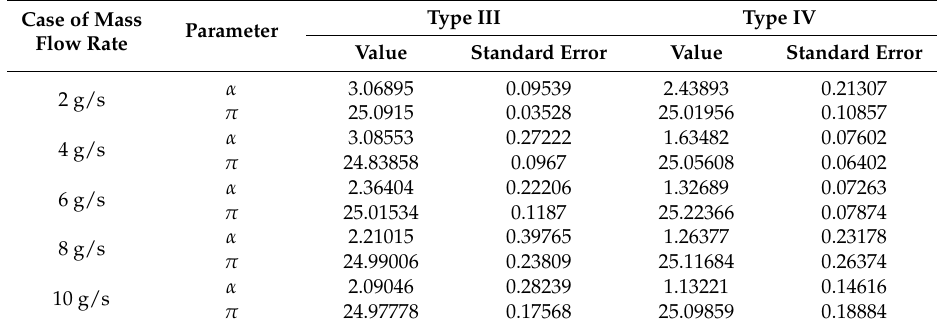
Figure 1. Effect of inflow temperature (unit K is necessary for thermodynamic calculation) on SOC under different mass flow rates (unit g/s is used here only for simplifying the legends) for ( a ) Type III tank and ( b ) Type IV tank (Symbol: data [14], Line: fitting). Table 1. Parameter values for effect of inflow temperature on SOC under different mass flow rates.